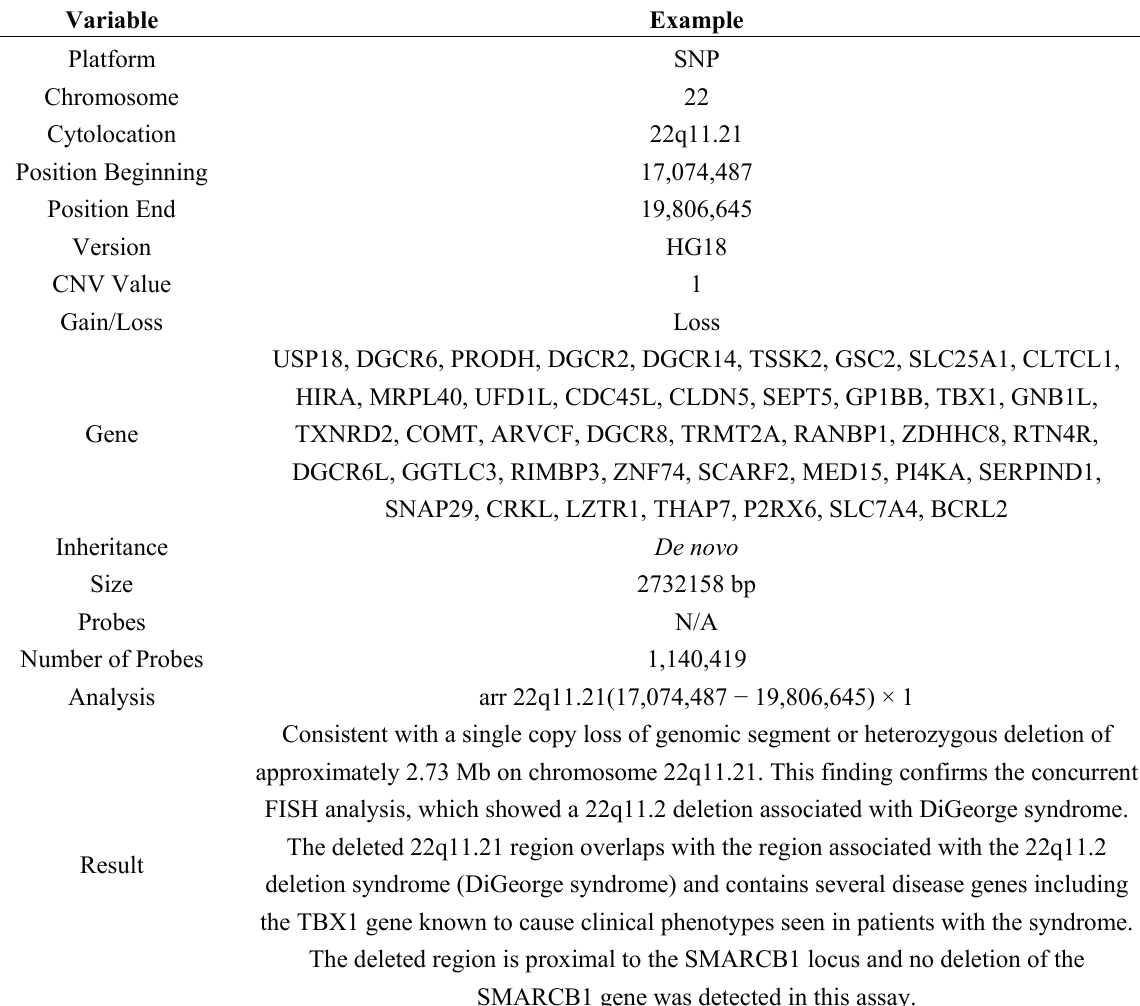
Table 1. Cytogenetic Data